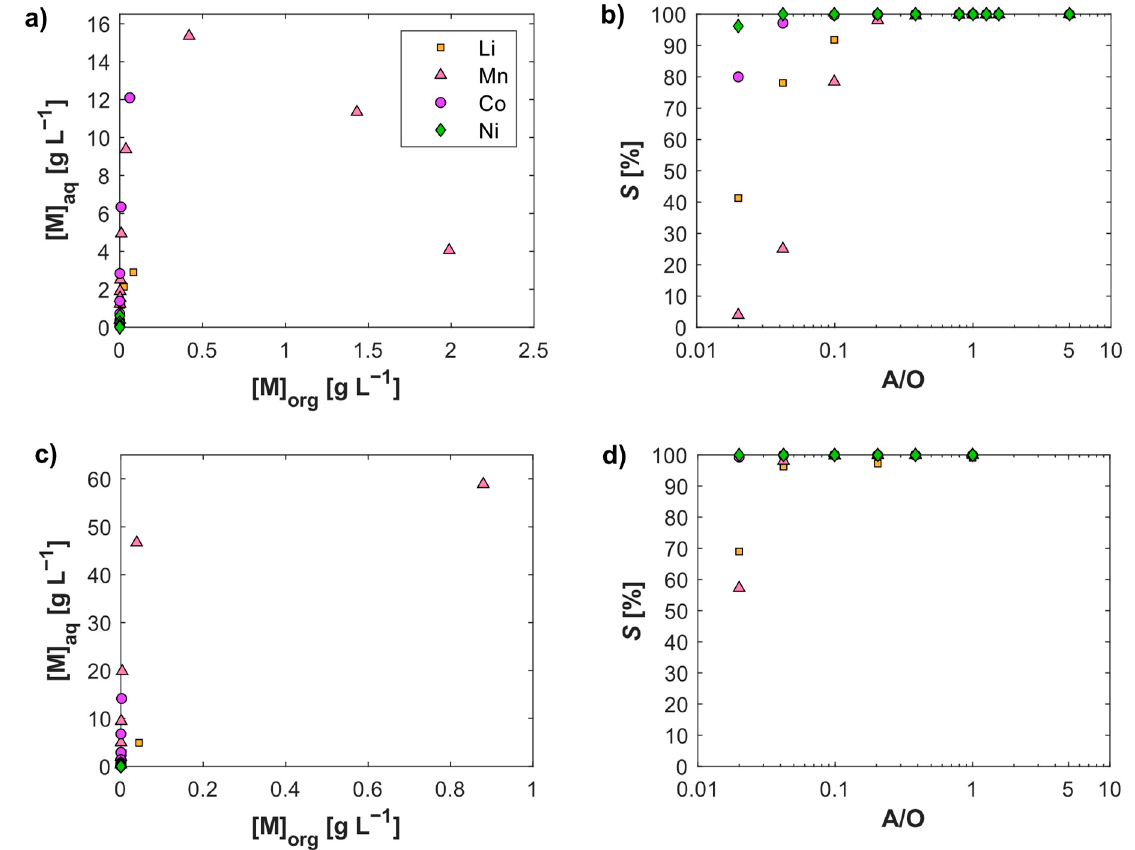
Figure 6. Backextraction of Li, Ni, Co, and Mn by H 2 SO 4 from loaded 0.8 M D2EHPA (modified by 5 vol-% TBP and diluted in Exxsol D80). T = 25 ± 1 ◦ C; t eq = 15 min. Initial concentrations in 5 vol-% TBP and diluted in Exxsol D80). T = 25 ± 1 °C; t eq = 15 min. Initial concentrations in the organic phase [g L − 1 ]: Li: 0.15; Ni: 0.01; Co: 0.3; Mn: 2.02. Subfigures: ( a ) Distribution of metals in